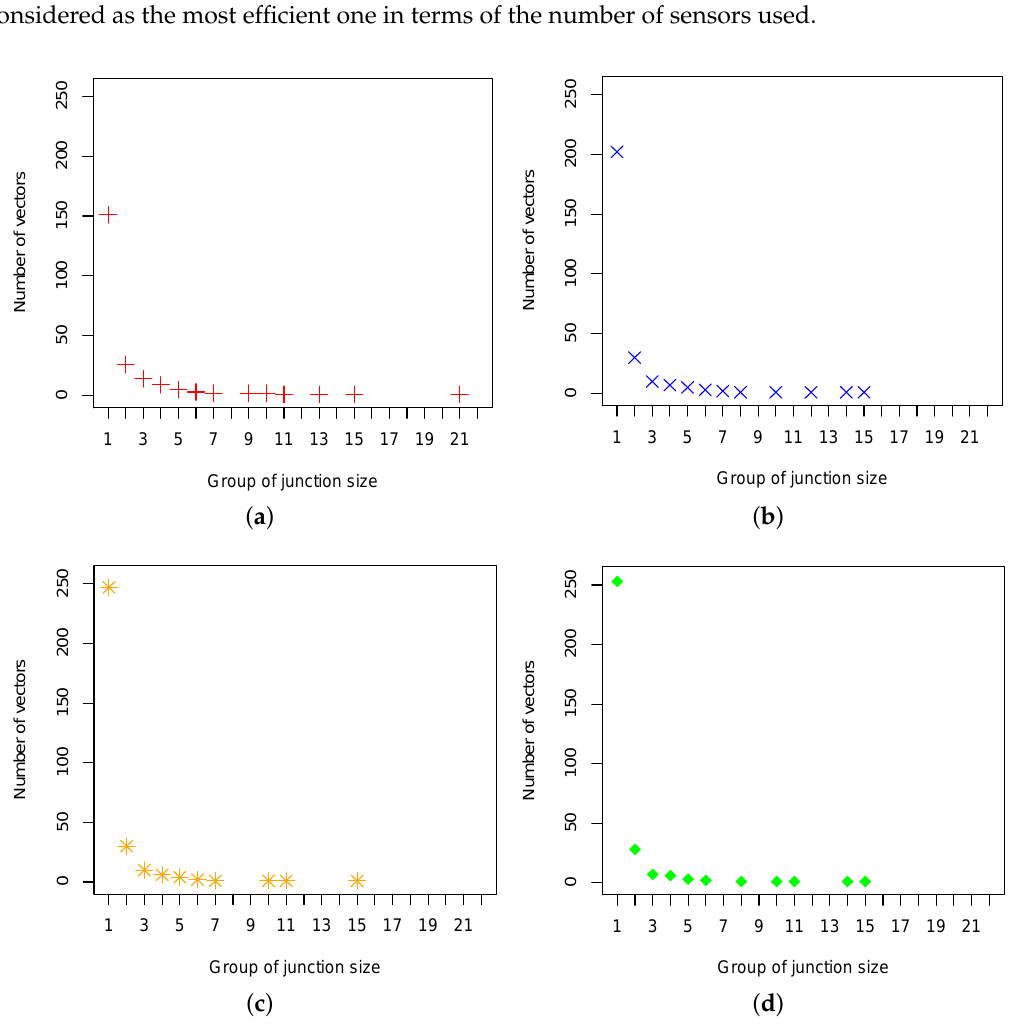
Figure 7. Number of vectors covering group of junctions from ( a ) 5 sensors ( b ) 10 sensors ( c ) 15 sensors ( d ) 20 sensors indicated by the +, x, ∗ , and (cid:5) symbols in each respective